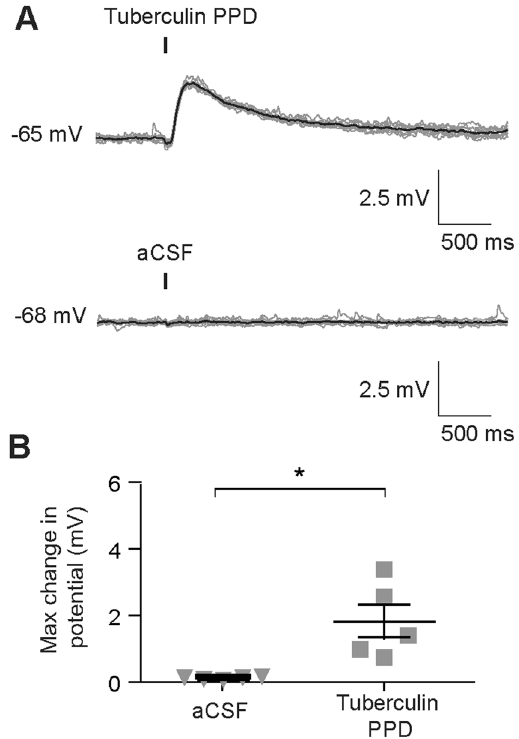
Figure 5. Application of Tuberculin Purified Protein Derivative (PPD) using Openspritzer causes neuronal depolatization of hippocampal neurons. Whole-cell current clamp recordings were performed from CA3 hippocampal pyramidal neurons to explore the effect of directly applied Tuberculin PPD. ( A ) 10 sweeps (grey) demonstrate a modest depolariztion in response to 20 ms puffs of Tuberculin PPD directed at the cell soma. Mean response in black. ( B ) Application of aCSF as a control did not result in changes to membrane potential. ( C ) Population data depicts this statistically significant difference, * p < 0.05,